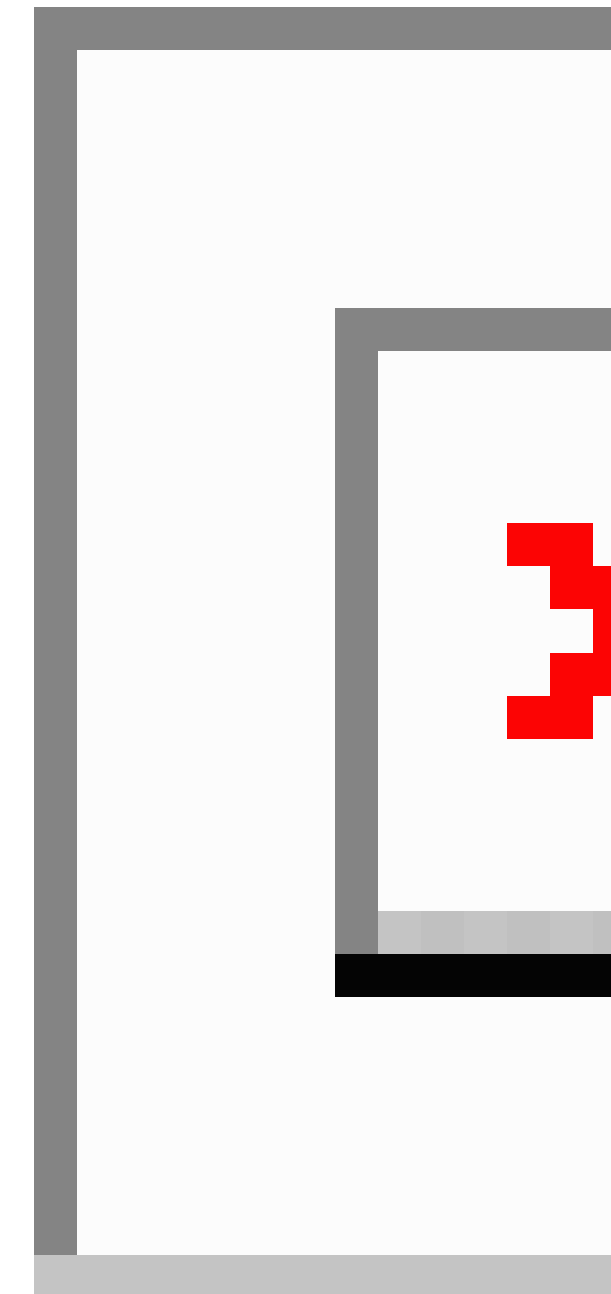
Figure 1. Overview of the ECO